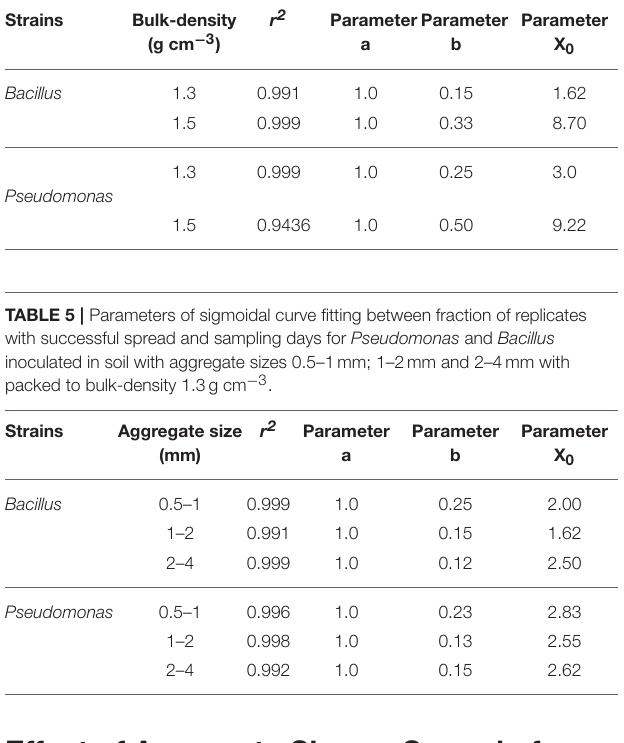
TABLE 4 | Parameters of sigmoidal curve fitting between fraction of replicates with successful spread and different sampling days for Pseudomonas and Bacillus